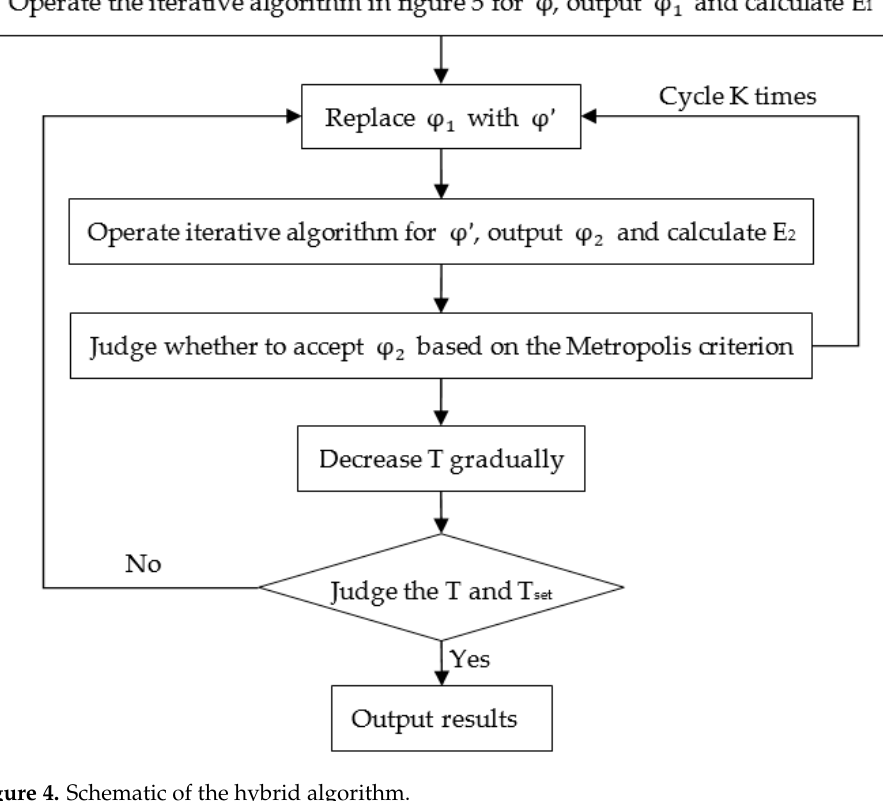
Figure 4. Schematic of the hybrid algorithm.